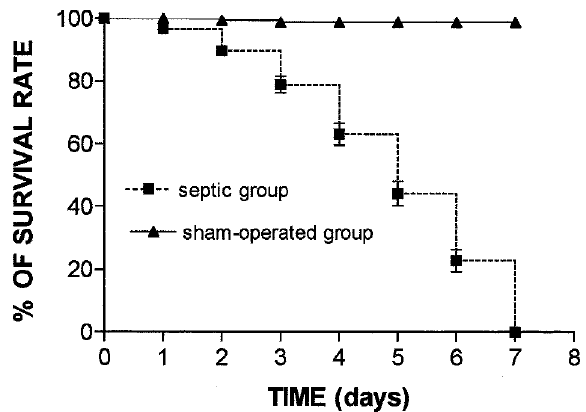
FIG. 1. Median survival rates of the septic mouse group. Each symbol represents the median of at least 10